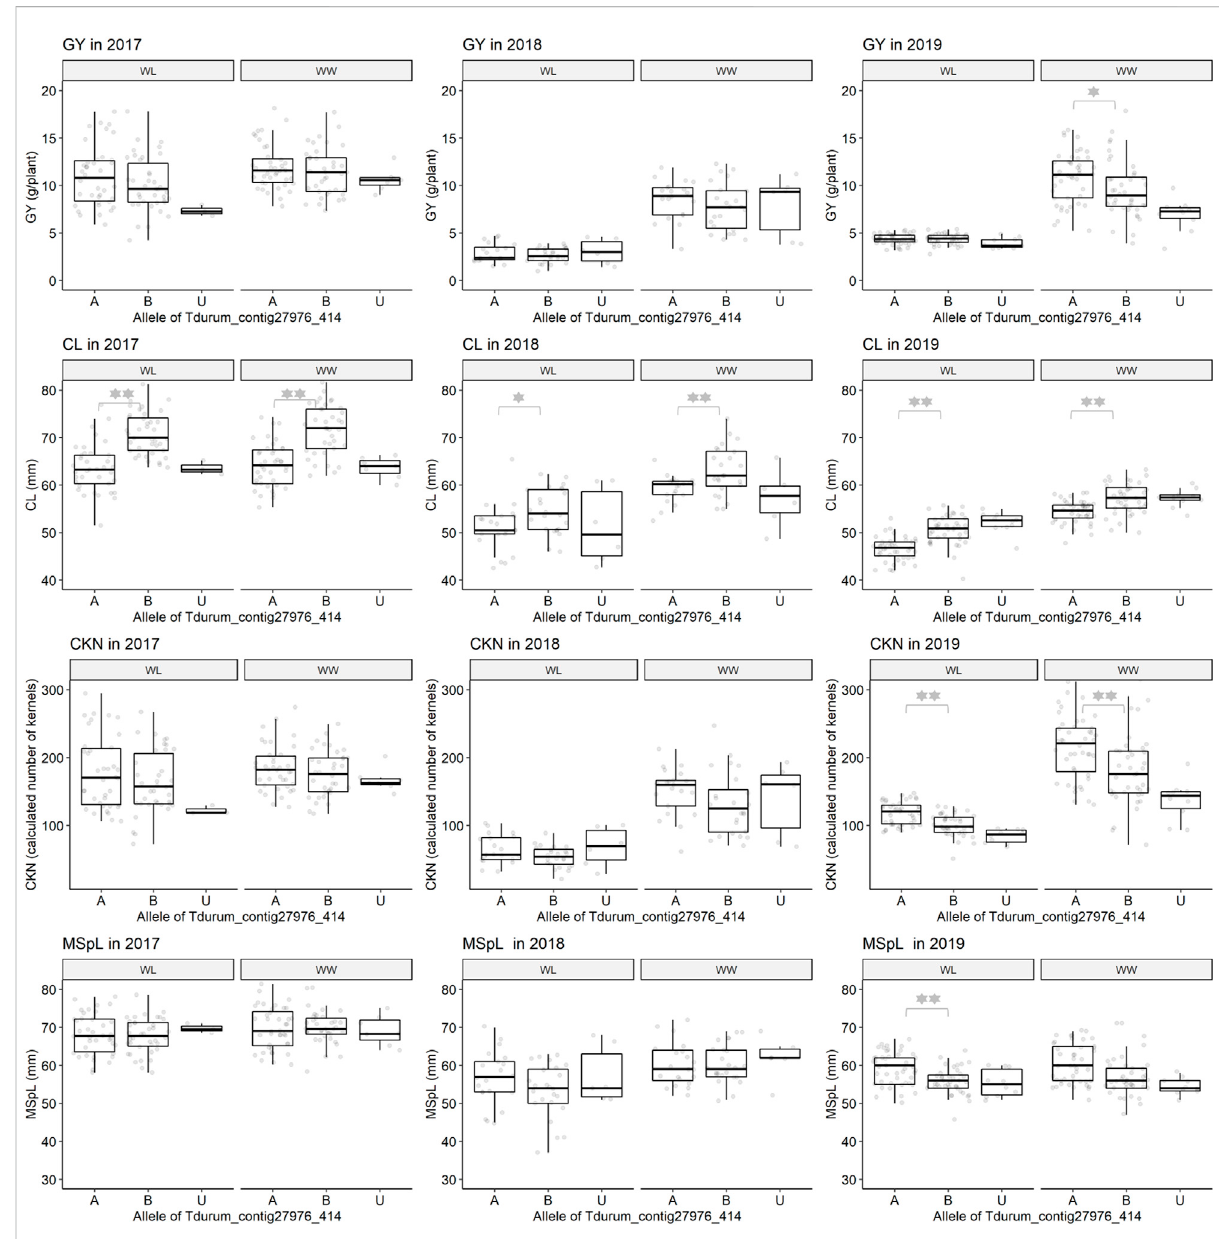
FIGURE 4 Grain yield (GY), culm length (CL), calculated kernel number (CKN), and main spike length (MSpL) of segmental sub-NILs with G18-16 or Uzan alleles oftheiSelect markerTdurum_contig27976_414.AandBAlleles werederived fromG18-16orUzan,respectively. Valuesobtained for theelite parent Uzan (U) were illustrated separately. Signi fi cant differences between groups of genotypes with the different alleles of Tdurum_contig27976_414 were calculated with a two-sided t -test. p -values ≤ 0.05 or 0.01 were marked with one or two stars,